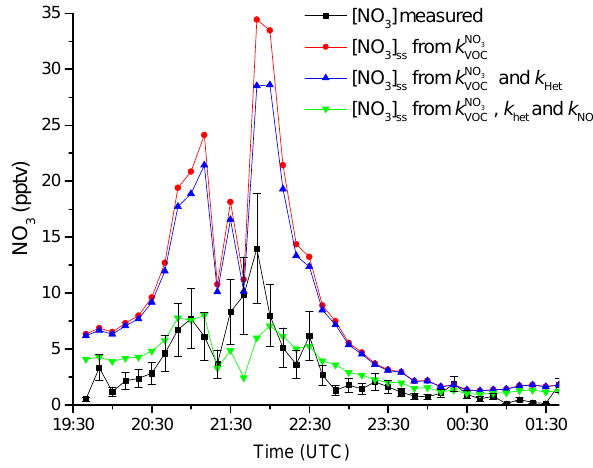
Figure 7. Comparison of measured NO 3 mixing ratio (black) with calculated stationary-state mixing ratios using k NO 3 k Het (blue), and k NO 3 , + k Het + k NO (green). VOC k NO 3 OTG